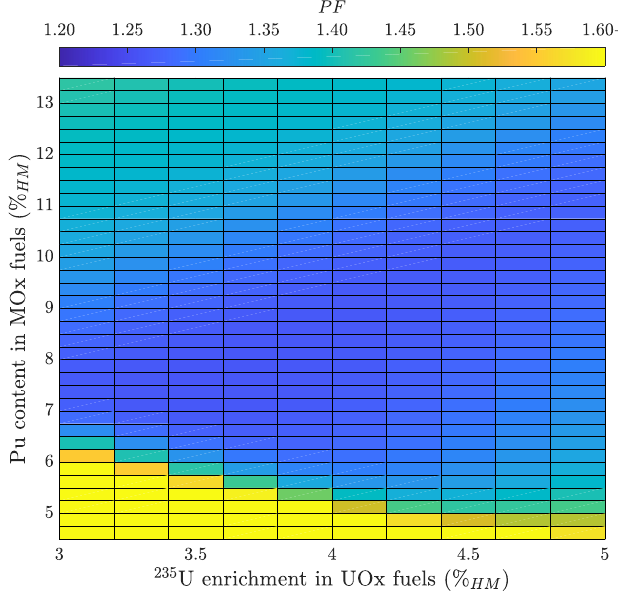
Fig. 9. Power peaking factors ( PF ) calculated for different Pu content and 235 U enrichment combinations with a fixed standard isotopic